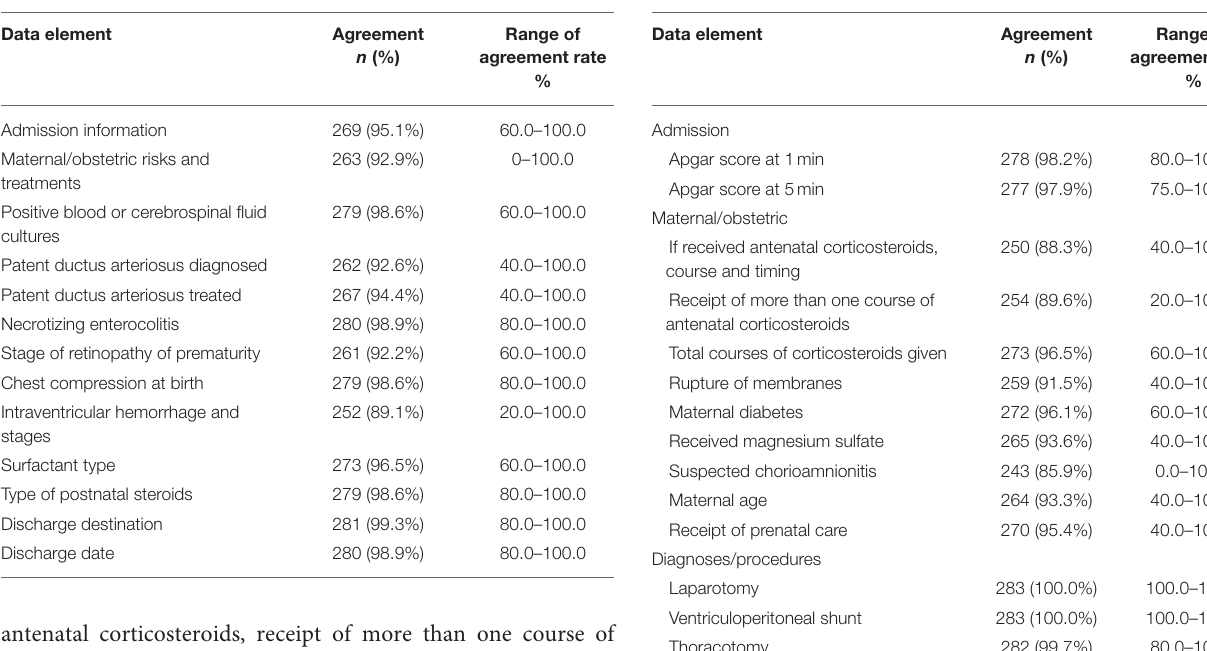
TABLE 2 | Agreement number and percentage for critical variables. TABLE 3 | Agreement number and percentage for important